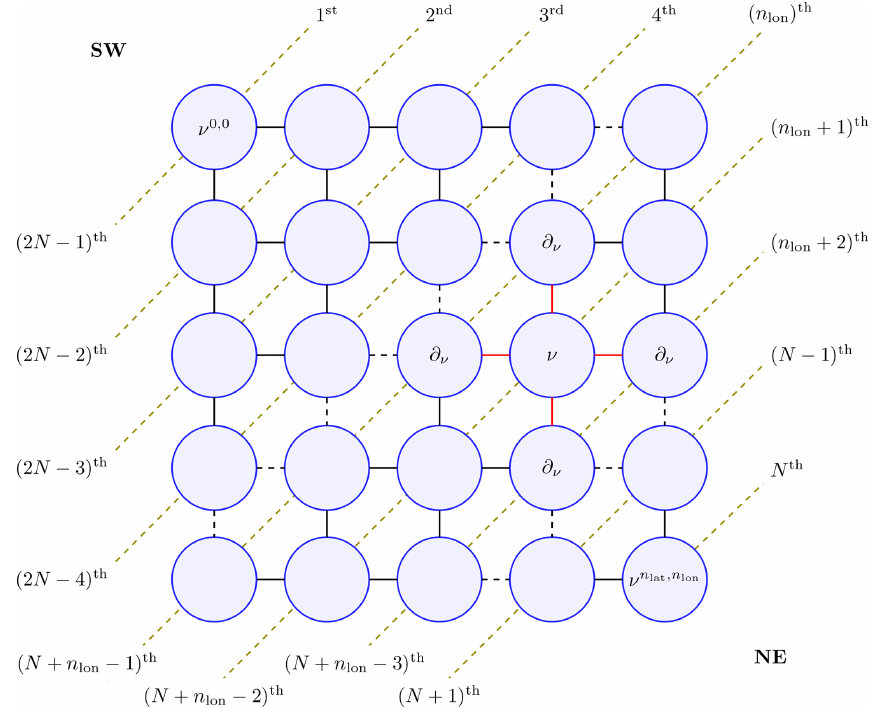
Figure 2. The marginal distribution p(ν) of vertex ν is conditional only on the neighbors in ∂ ν (connected to ν with red edges) due to the Markov structure in the pictured lattice graph. For effective solving, the vertices on the diagonal dashed lines are computed simultaneously making the algorithm non-exact. The order numbers labeling the diagonal lines represent an ordering in which the diagonals can be computed in parallel to get all the marginals in O (N) wall time, where N (cid:44) n lat + n lon − 1. Southwest and northeast corners of the domain are labeled SW and NE in the graph. The final values of the parameters are obtained when diagonals from N to 2 N − 1 are